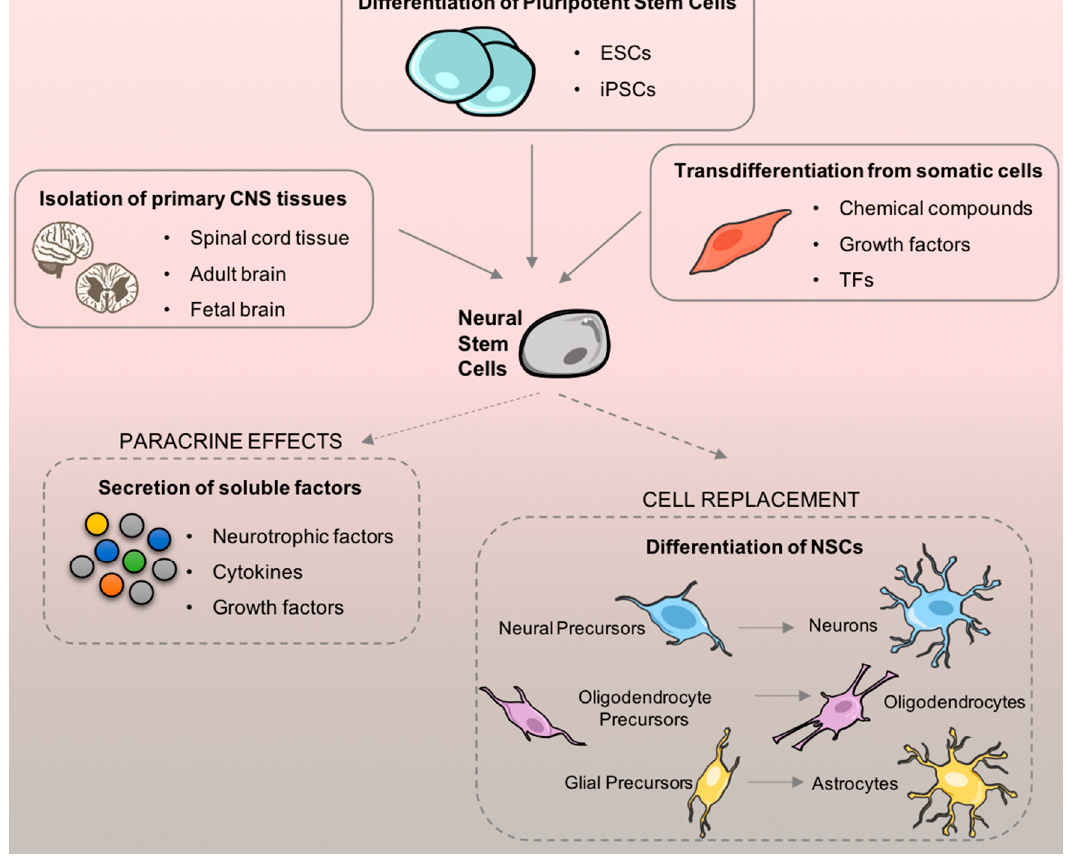
Figure 5. Neural stem cell (NSCs) sources and their therapeutic applicability after cell transplantation. There are three main sources to generate NSCs: isolation from primary central nervous system (CNS) tissue; differentiation of pluripotent stem cells, and lineage reprogramming of somatic cells. After obtaining a considerable number of cells that fulfill the needs of cell transplantation cells can be applied. Once on the injury site, NSCs can be differentiated and also secrete paracrine factors that may also support neurological repair.